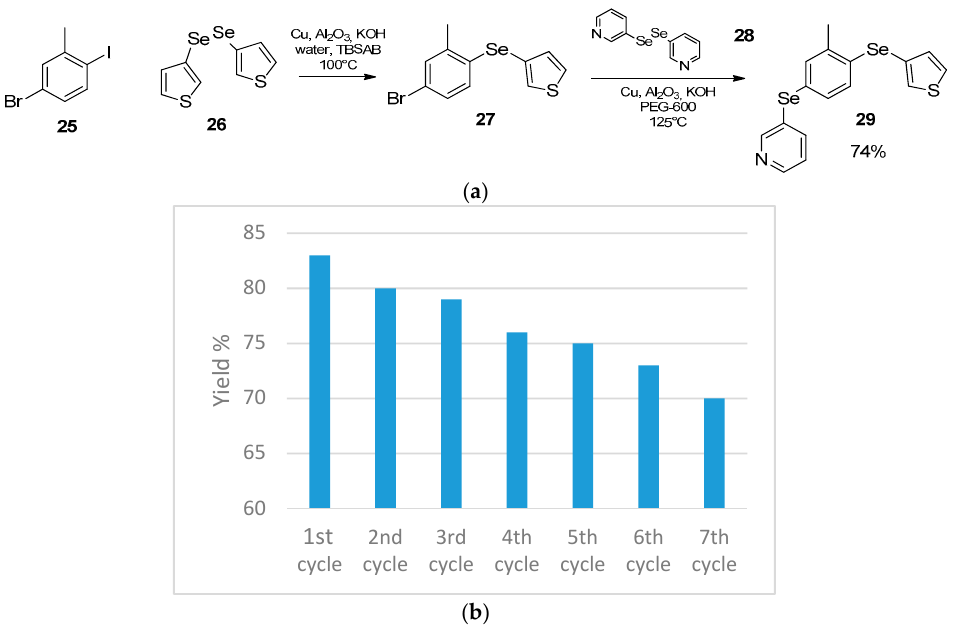
Figure 16. ( a ) Synthesis of the bisselenide 29 ; ( b ) Reuse of the catalyst in the reaction of 4-iodoanisole and diphenyl diselenide.